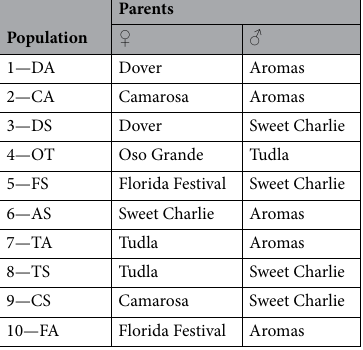
Table 5. Intraspecific crosses used to obtain 10 segregating strawberry ( Fragaria × ananassa Dusch.)